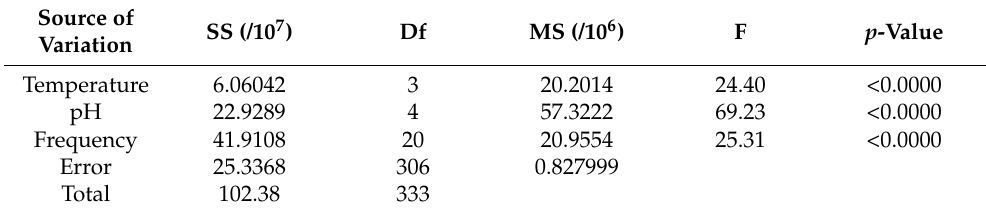
Table 13. Two-Way ANOVA results for Vpp with selected data. Source of